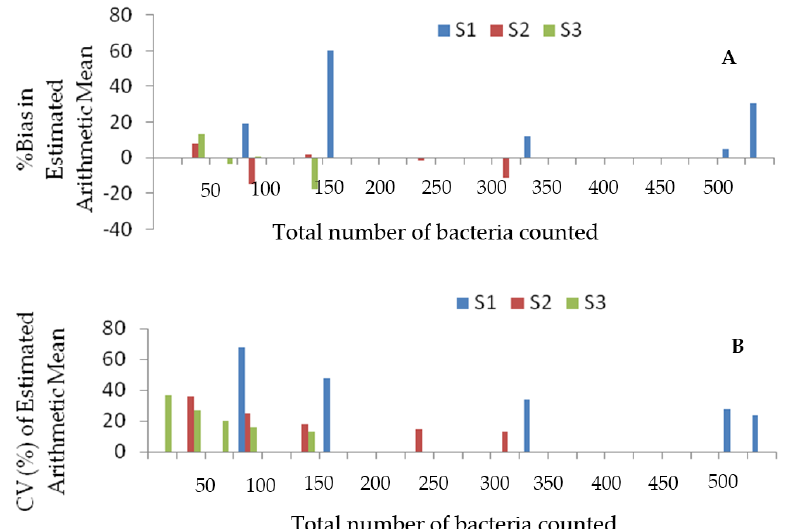
Figure 8. Plots showing the variations in the arithmetic mean estimated in each of the samples S1, S2 and S3 in terms of ( A ) percentage bias and ( B ) coefficient of variation (%). The total number of bacteria counted from each of 5, 10, 20, 30 and 40 fields of view is shown along x -axis while the respective values of percentage bias or coefficient of variation (%) are shown along y -axis.